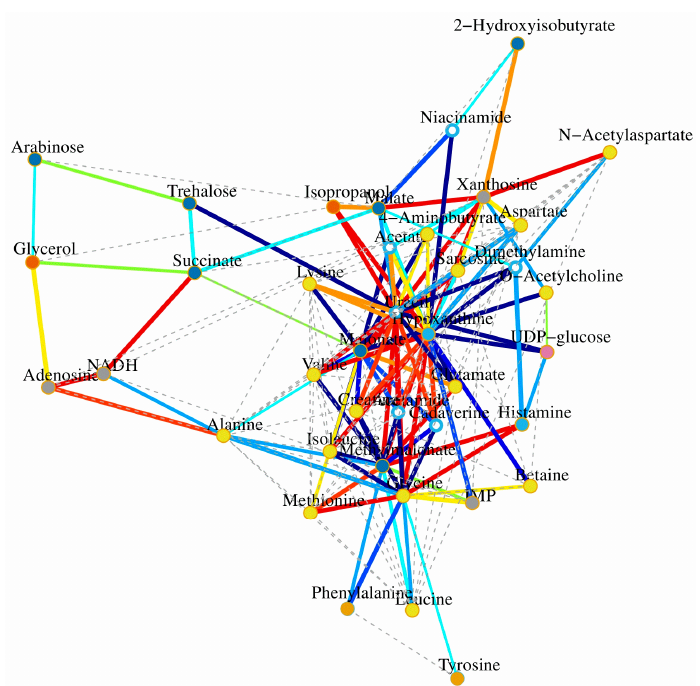
Figure 7. Correlation network determined by canonical (sparse-partial least squares, sPLS) analysis using metabolite concentrations as X variables and other parameters as Y variables. The network is graphically represented with metabolites and parameters as nodes, and correlations above a threshold (0.8) as edges (color coded according to the correlation coefficients, bluish for negative and reddish for positive correlations).